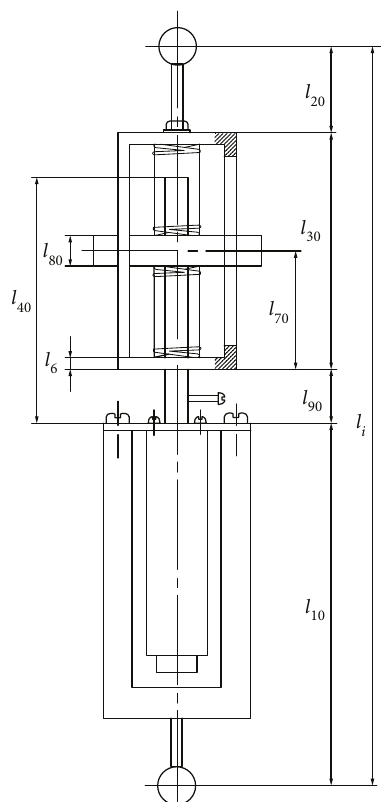
Figure 4: Structural model of the individual branch